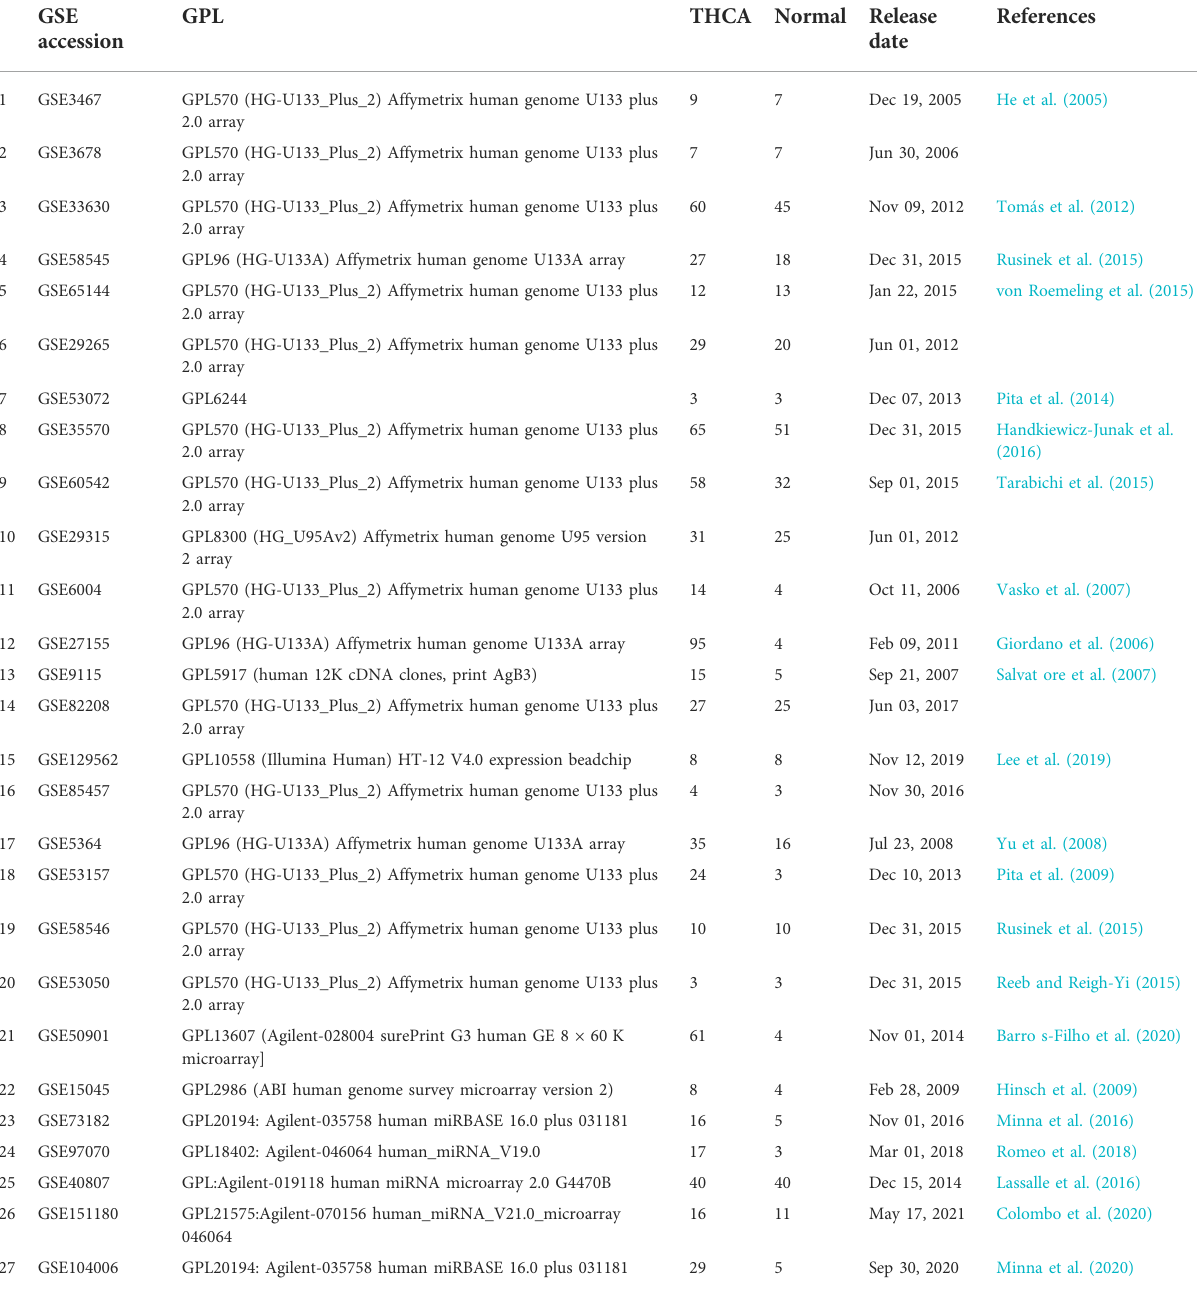
TABLE 1 Characteristics of the datasets used for the large-scale acquisition of differentially expressed genes (DEGs) andmicroRNAs (miRs) in thyroid cancers. GSE accession